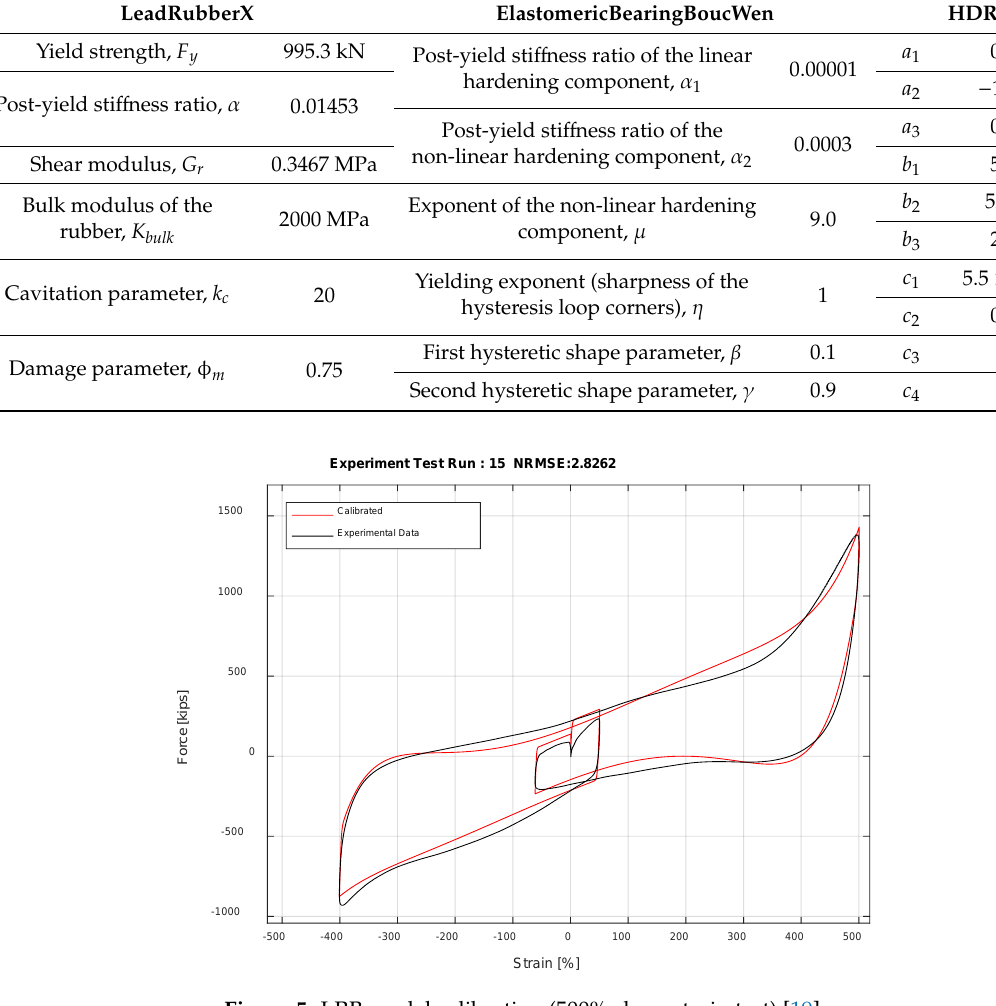
Figure 5. LRB model calibration (500% shear strain test) [19].